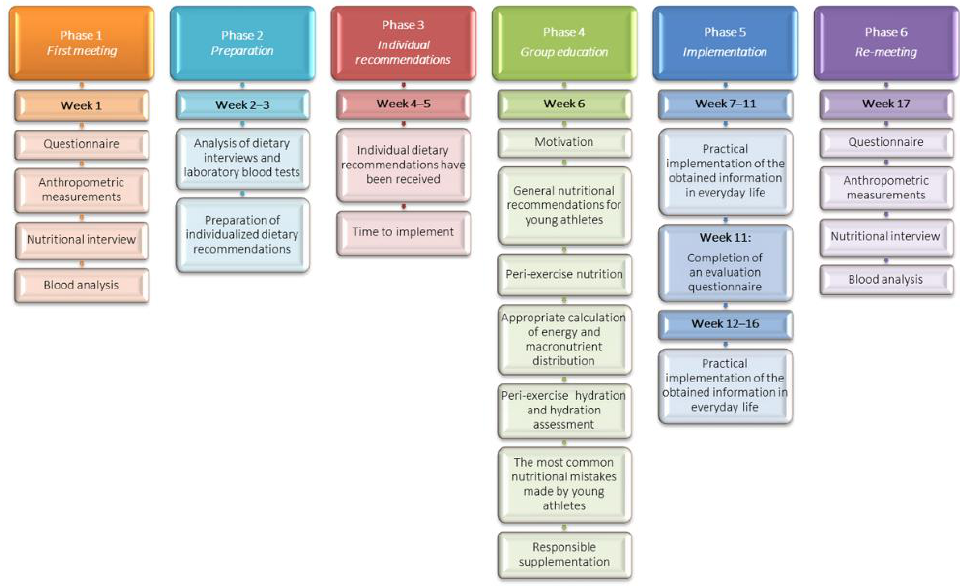
Figure 2. Scheme of the phases of the conducted research.